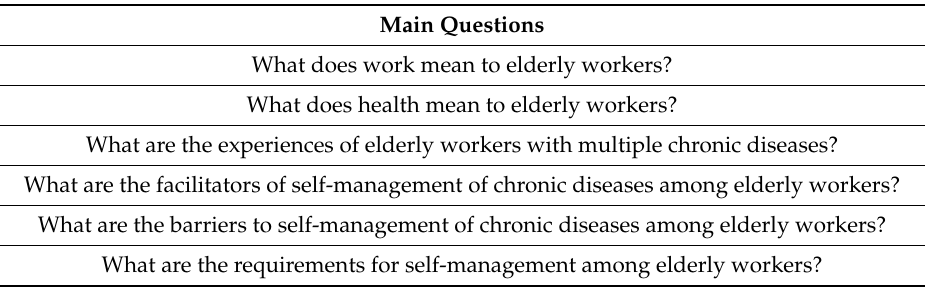
Table A1. Interview